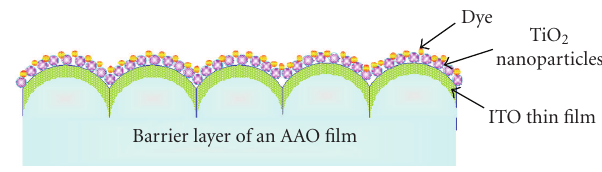
Figure 1: Schematic illustration of the proposed 3D nanostruc- tured TiO 2 /ITO/AAO